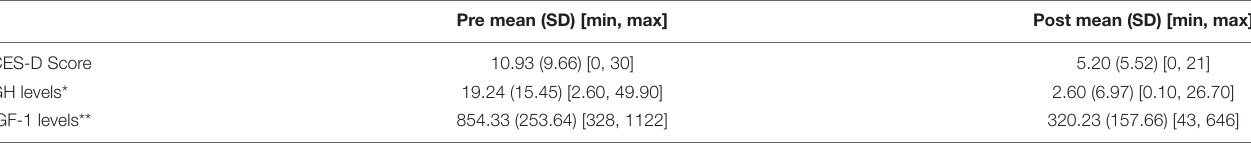
TABLE 1B | Summary statistics of measurements for acromegaly patients ( n = 15).